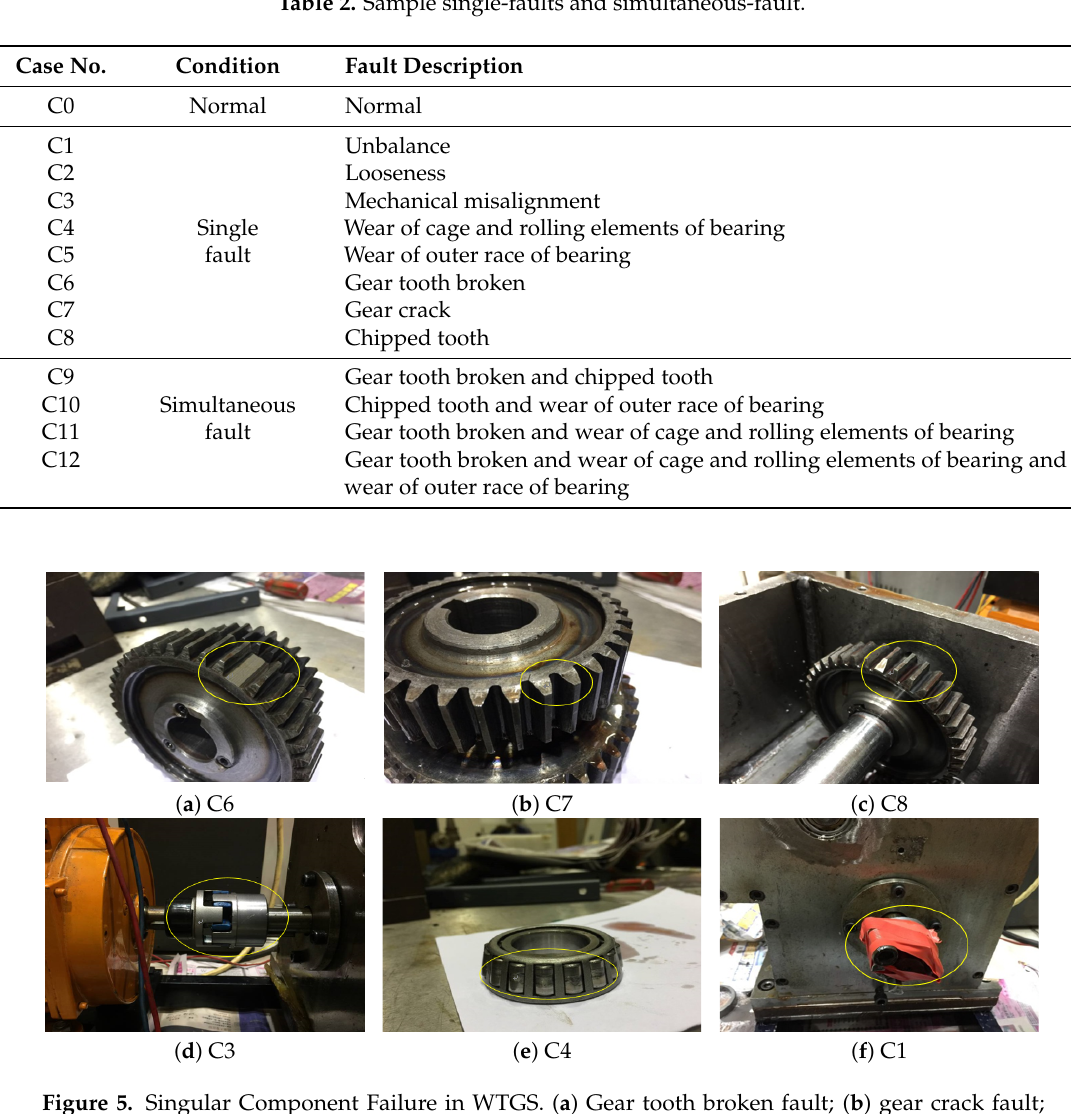
Table 2. Sample single-faults and simultaneous-fault.